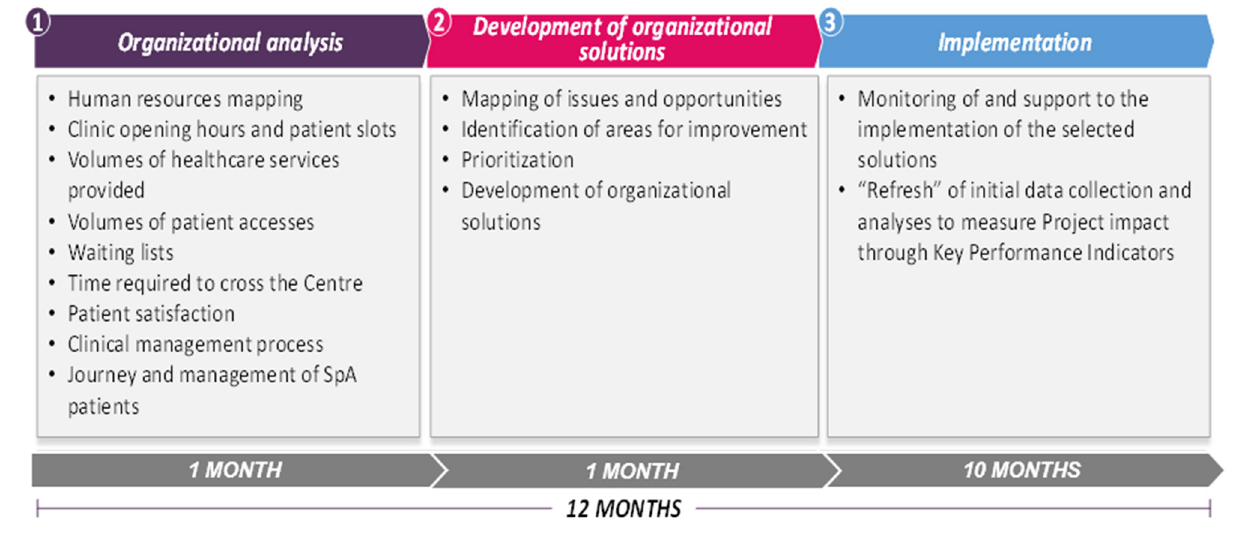
FIGURE 2 | Overview of the “Early SpA Clinic” phases and